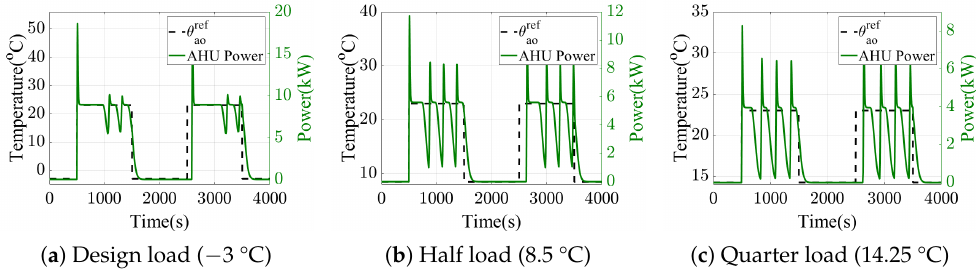
Figure 7. AHU system power consumption with H ∞ controller at three different thermal load conditions (square wave input).